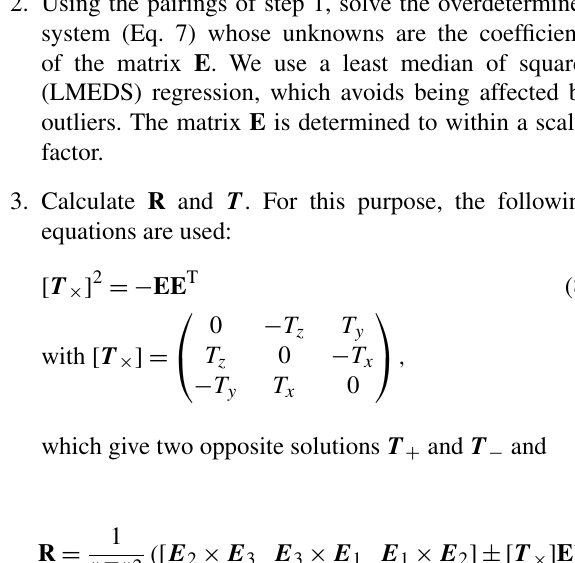
(cid:16) (cid:17) (cid:16) (cid:17) u M ,v M u M ,v M and are row-aligned 1 1 2 2